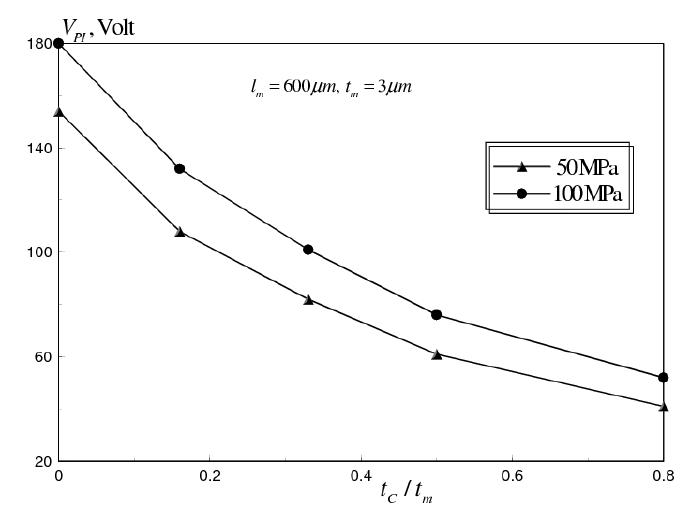
Figure 14. Effect of corrugation thickness ratio on V switch at σ range of 50–100 MPa ( l M ω = 30